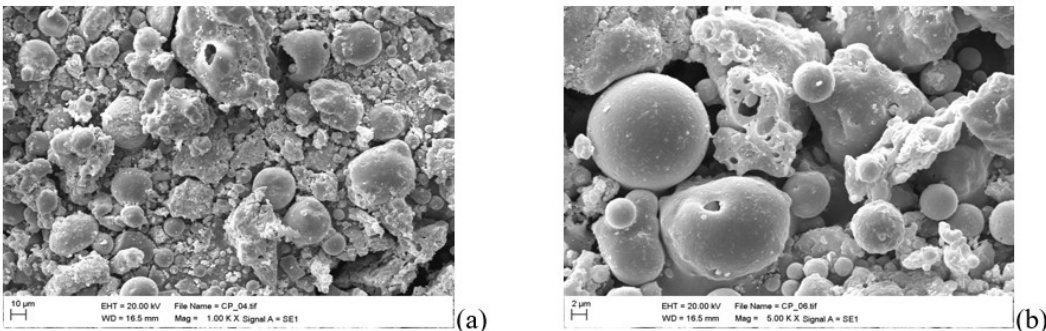
Table 3 - Chemical composition of fly ash obtained by EDS Spectrum